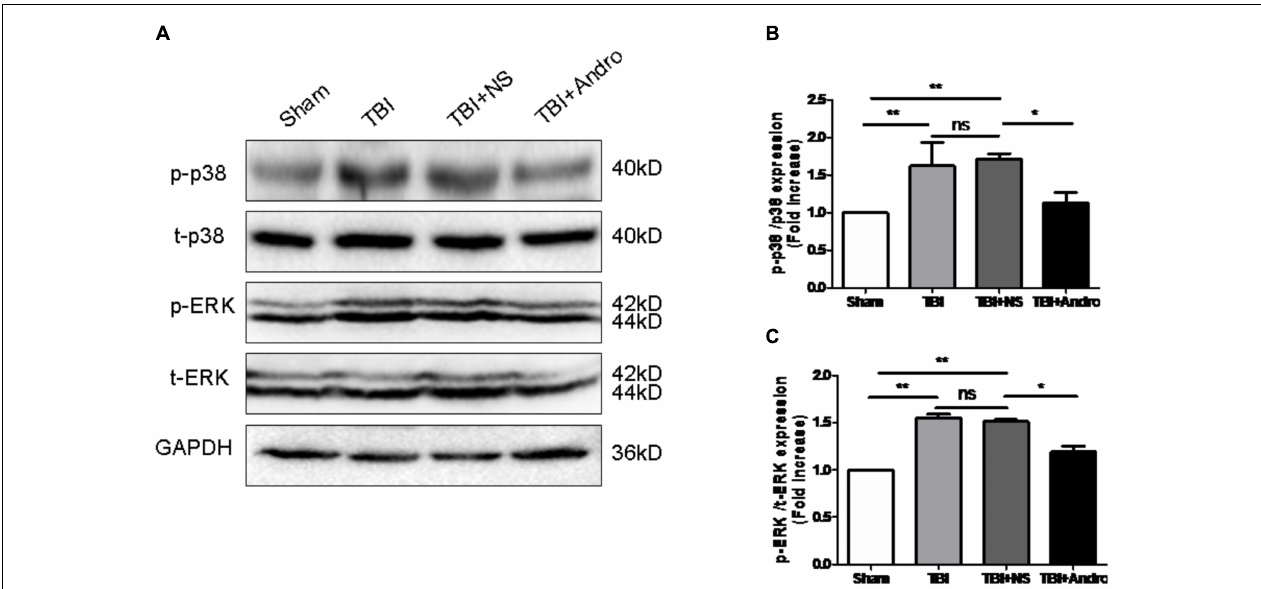
FIGURE 6 | Andro treatment inhibited the phosphorylation of p38 MAPK and ERK after TBI. (A) The expression levels of p-p38 MAPK and p-ERK in peri-contusive cortex were examined by Western blot analysis at 24 h after TBI. Relative expression levels of p-p38 MAPK (B) and p-ERK (C) were calculated based on densitometry analysis. The mean values of p -p38 MAPK and p -ERK in the sham group were normalized to 1.0. All data are presented as the mean ± SD. ∗ p < 0.05, ∗∗ p < 0.01 ∗∗∗ p < 0.001, ns p > 0.05; n = 6 in each